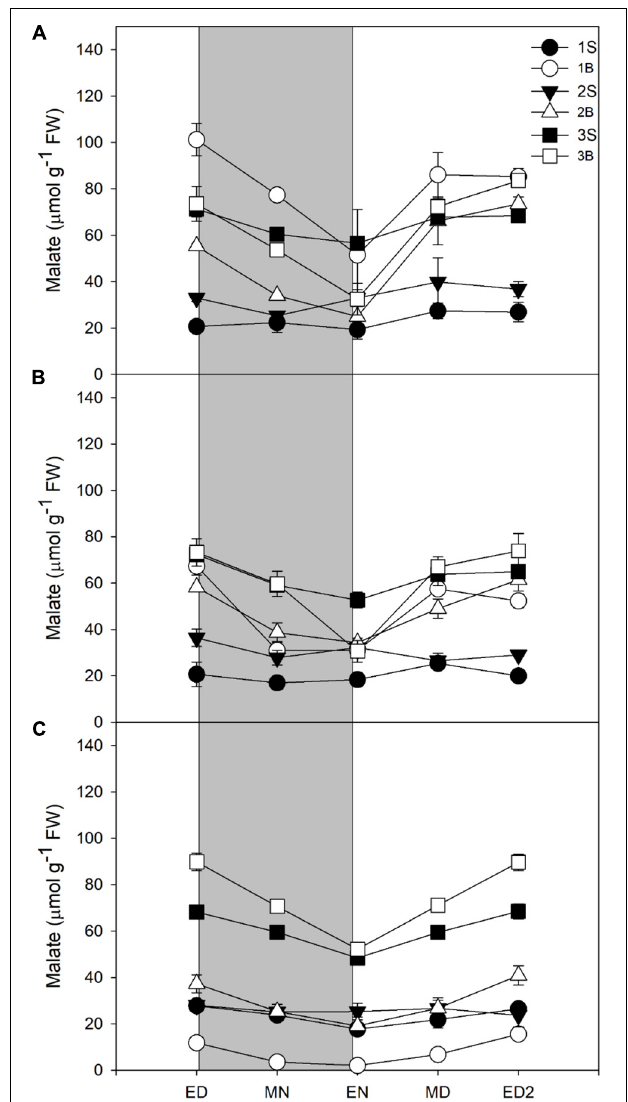
FIGURE 4 | Diurnal malate levels of barley cv. Propino plants grown under three light intensities. Malate levels of plants grown for (A) 14 DAS under 500 µ mol photons m − 2 s − 1 (HL), (B) 16 DAS under 300 µ mol photons m − 2 s − 1 (ML) and (C) 18 DAS under 100 µ mol photons m − 2 s − 1 (LL), until third leaf stage. Plants were grown in a 16 h:8 h light:dark photoperiod 22 ◦ C:18 ◦ C day:night. 1S: 1st leaf sheath; 1B: 1st leaf blade; 2S: 2nd leaf sheath; 2B: 2nd leaf blade; 3S: 3rd leaf sheath; 3B: 3rd leaf blade; ED: end of day; MN: middle of night; EN: end of night; MD: middle of day; ED2: end of subsequent day; FW: fresh weight; gray panels: night period; error bar represents SD; n = 3. All statistics are available in Supplementary Table 1